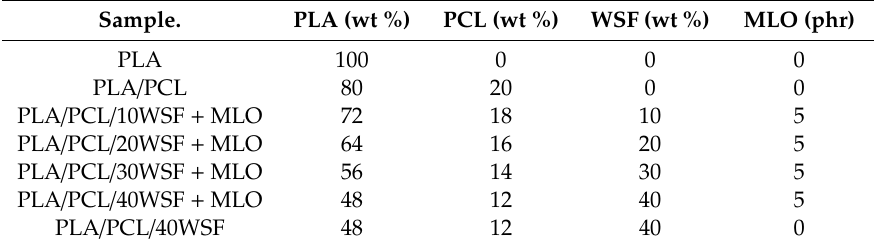
Table 1. Summary of compositions according to the weight content (wt %) of polylactide (PLA), poly( ε -caprolactone) (PCL), and walnut shell flour (WSF) in which maleinized linseed oil (MLO) was added as parts per hundred resin (phr) of PLA / PCL / WSF composite.